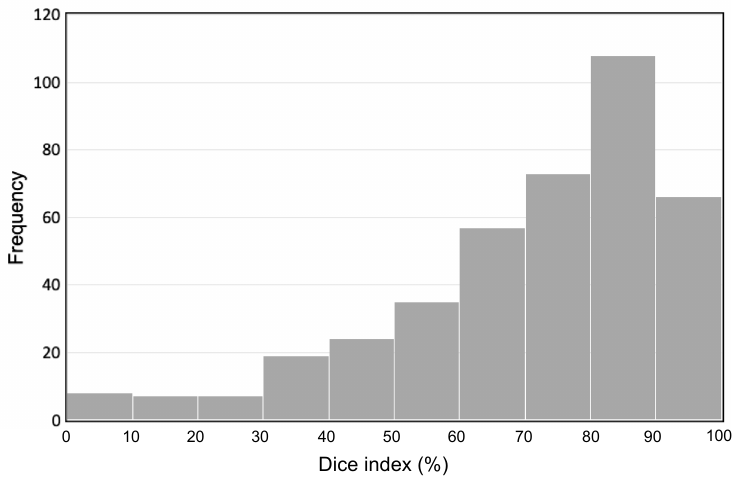
Figure 5. Histogram of the Dice index.